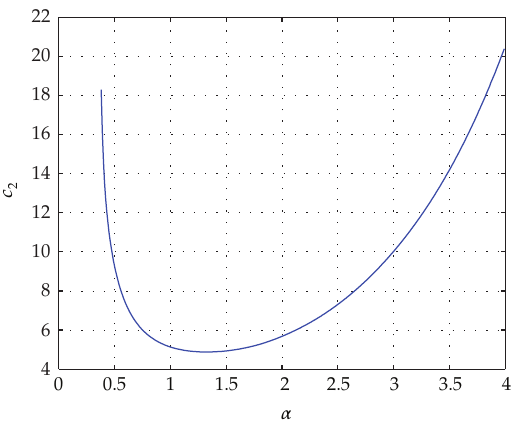
Figure 2: The local optimal bound of c 2